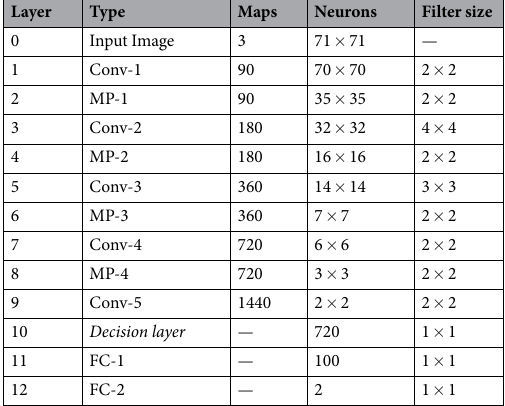
Table 2. Proposed deep learning approach.